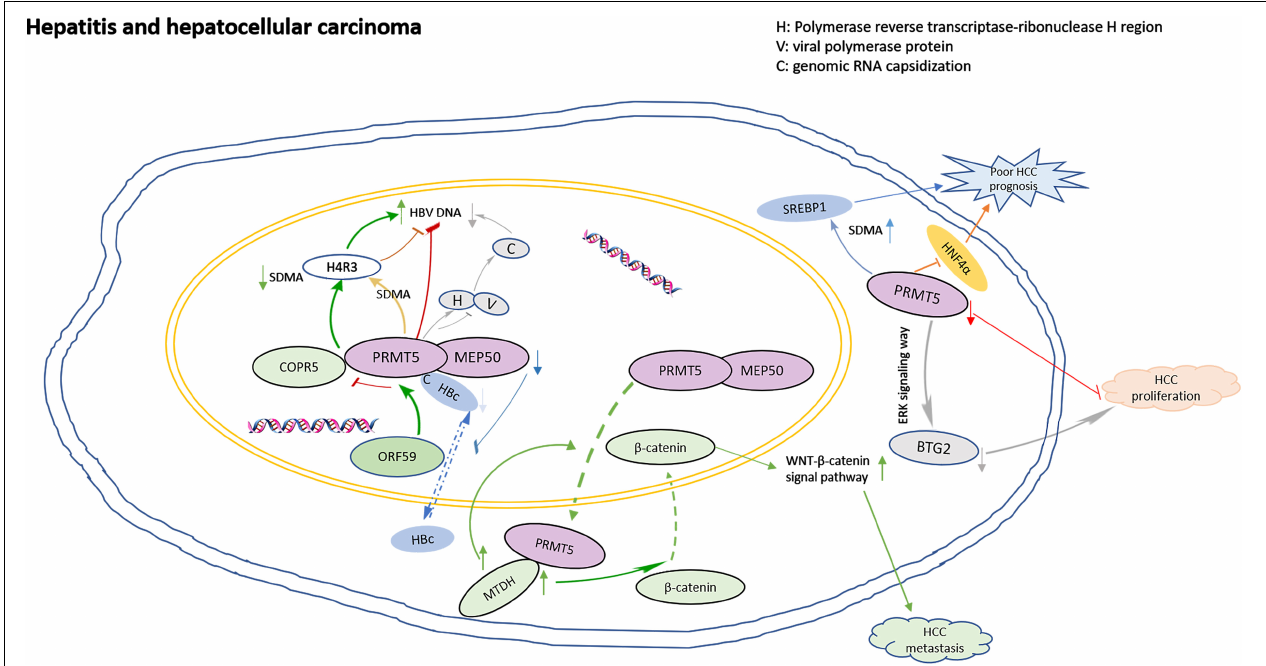
FIGURE 2 | The model for PRMT5 roles in regulation of hepatitis and hepatocellular carcinoma. ORF59 binds to the N-terminal domain of PRMT5, competitively destroying the binding of PRMT5 and COPR5, leading to the decrease of H4R3 SDMA levels and the increase of viral gene transcription; PRMT5 blocks polymerase by binding to the reverse transcriptase ribonuclease H region of the polymerase, interfering with the capsizing of genomic RNA; HBV core protein (HBc) interacts with PRMT5 and MEP50 through its C-terminal arginine-rich domain, and arginine methylation could regulate the nuclear to cytoplasmic shuttle of HBC protein. Down-regulation of PRMT5 and MEP50 decreased the level of HBC protein in nucleus. When MTDH is overexpressed in HCC cells, PRMT5 transfers from the nucleus to the cytoplasm, and then β -catenin transfers from the cytoplasm to the nucleus, and the WNT- β -catenin signaling pathway is upregulated. MTDH-PRMT5 complex could promote the metastasis of HCC by regulating WNT- β -catenin signaling pathway. PRMT5 leads to the down regulation of tumor suppressor BTG2 expression through ERK pathway, and consequently accelerated HCC proliferation. PRMT5 antagonizes the expression of HNF4 α and resulted in poor